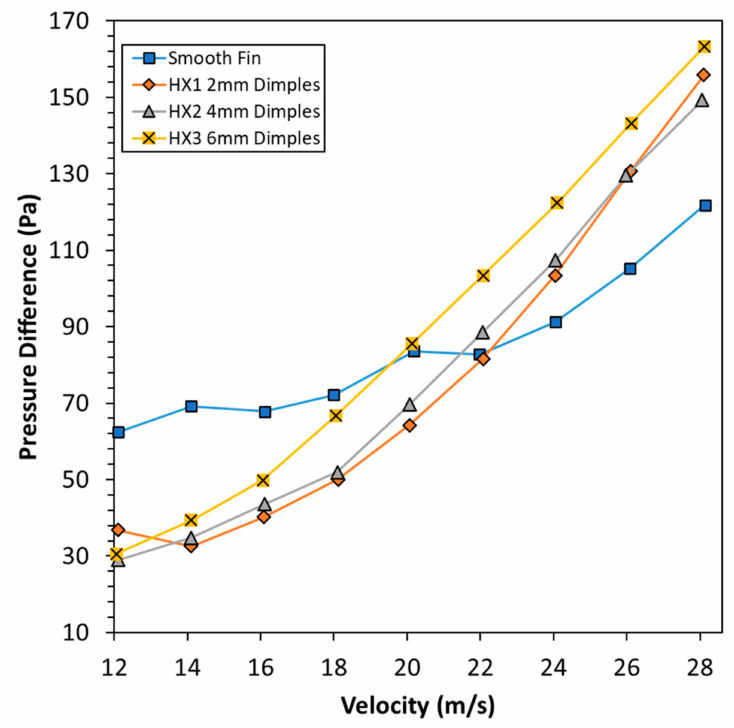
Figure 11. Comparison of pressure drop between smooth, 2 mm, 4 mm and 6 mm dimples engraved on NACA/elliptical